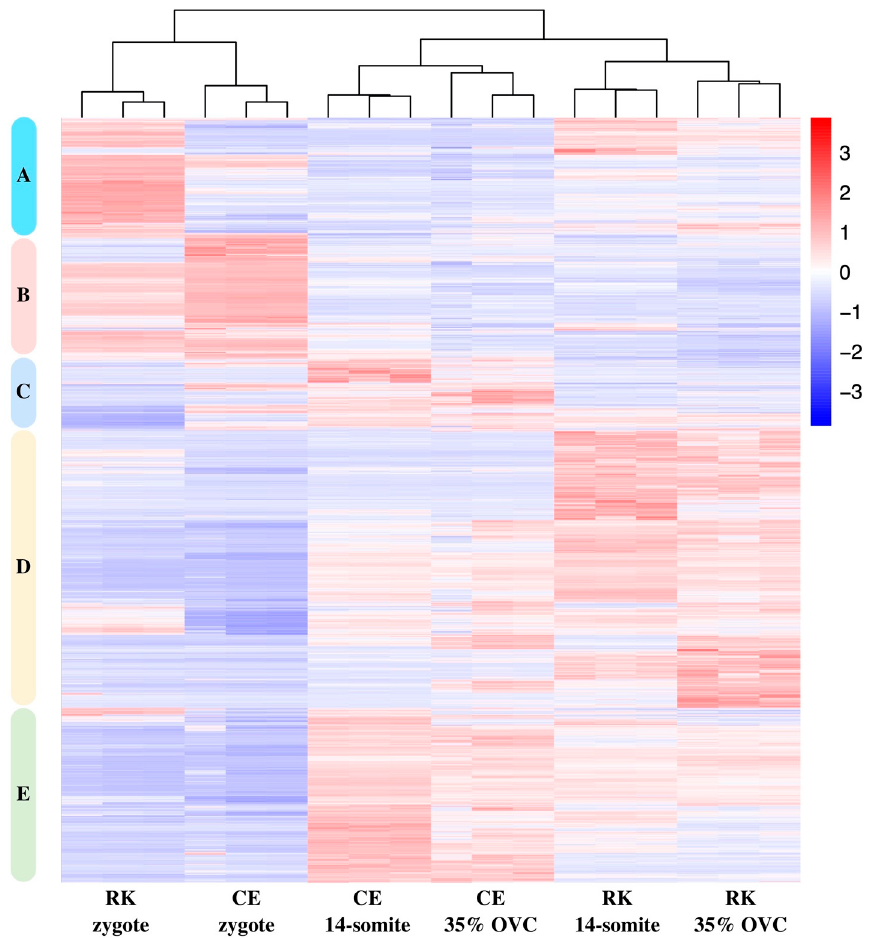
Figure 8. Cluster heatmap of differentially expressed genes between CE and RK goldfish. The colors correspond to gene expression levels that were converted to Z-scores.